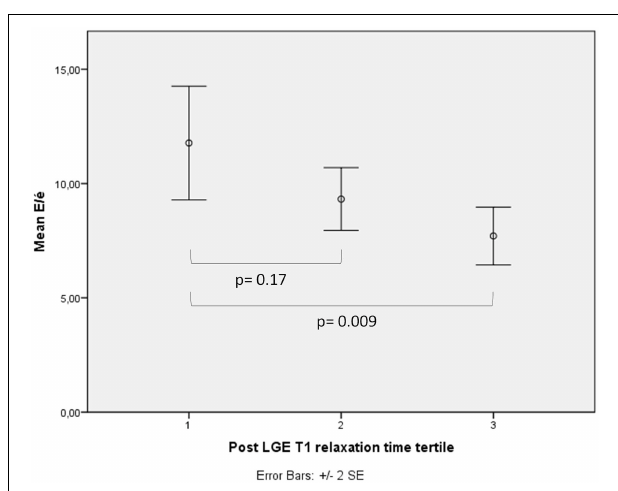
FIGURE 2 | The correlation between LGE T1 relaxation time and diastolic function. When subjects were divided into tertiles according to LGE T1 relaxation time (1st tertile had the shortest LGE T1 relaxation time and the highest amount of interstitial fibrosis) the 1st tertile had significantly more impaired LV diastolic function as measured by E/é-values compared to the 3rd tertile.